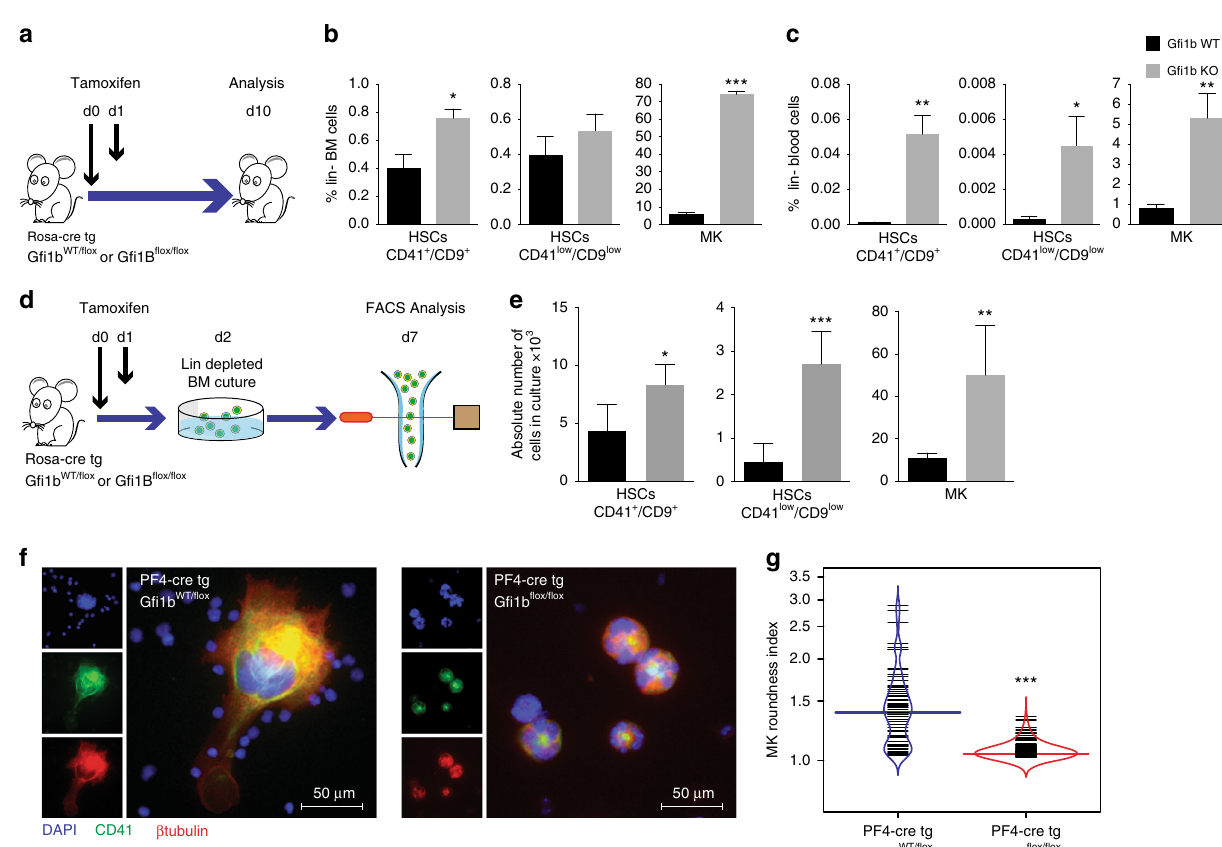
Fig. 1 Loss of G fi 1b in MKs and HCSs causes their expansion and mobilization into the blood. a Schematic of Tamoxifen injections; mice were analyzed by FACS at day 10 following the fi rst injection. b , c Quanti fi cation of G fi 1b WT/KO MKs and HSCs in lineage negative depleted BM and blood ( n = 3 mice per group). d Schematic of in vitro analysis of G fi 1b WT/KO HSCs and MKs expansion. e MKs and HSCs (CD41 low /CD9 low ) were taken into culture and were quanti fi ed by FACS at day six (day seven post Tamoxifen injection, n = 3 mice per group). f , g Loss of G fi 1b leads to impaired MKs spreading on Fibronectin coated matrix as quanti fi ed by calculating their roundness index ( n = 70 G fi 1b wt/ fl ox cells and 220 G fi 1b fl ox/ fl ox cells). (* p < 0.05, ** p < 0.001, *** p < 0.0001 on a Welch corrected t -test, error bars show